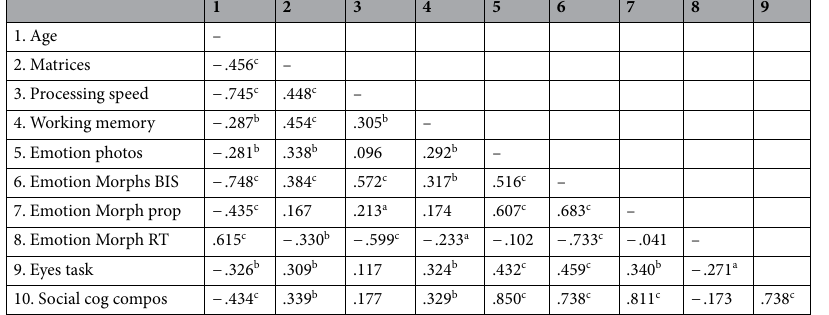
Table 2. Correlations between main variables in all participants. Age was treated as a continuous variable in the correlations. Emotion Morph BIS: Balanced Integration Score. Emotion Morph Prop: Proportion correct. Emotion Morph RT: reaction time. Social Cog Composite: the average proportion correct across three tasks tapping social cognition. a p < .05, b p < .01, c p < .001. (All tests